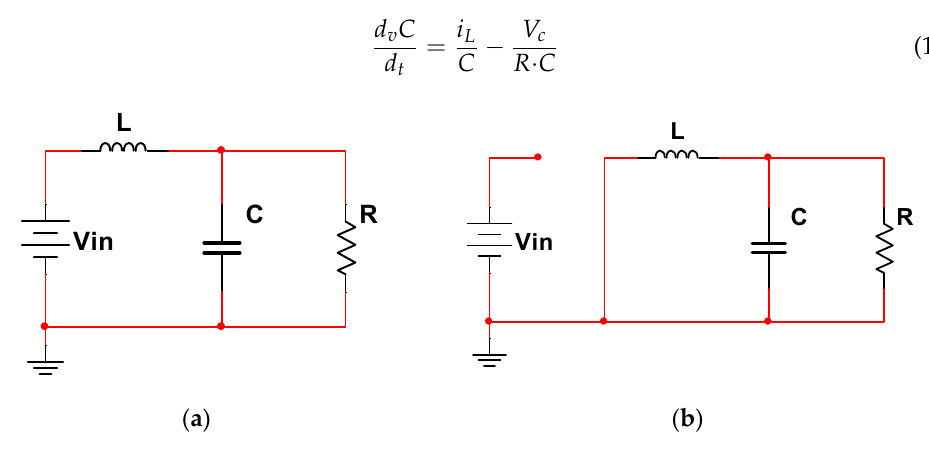
Figure 7. Buck’s operation modes. ( a ) Switch on; ( b ) switch off.